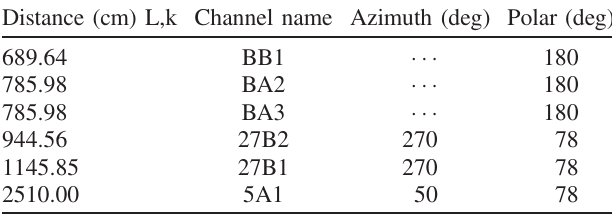
TABLE I. Source-to-detector distances L k (cm) and angular locations of nTOF detectors for MagLIF shot 2584 in standard spherical-polar coordinates. Azimuthal angles were measured relative to a fixed, locally defined direction.